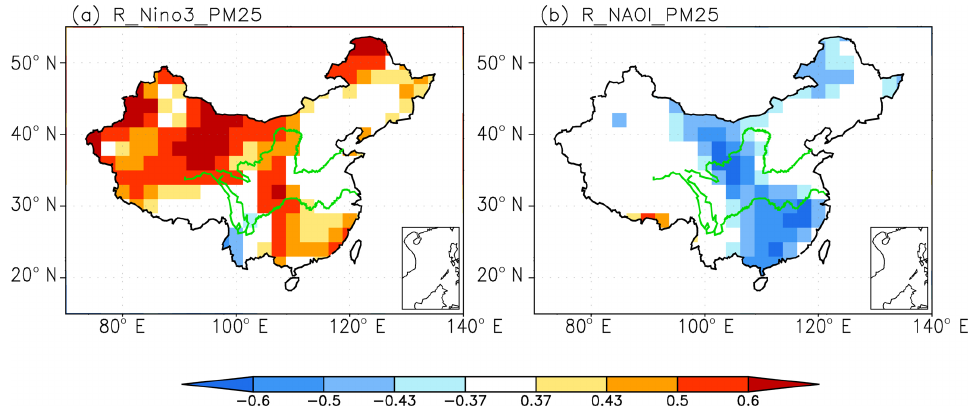
Figure 3. (a) The spatial distribution of the correlation coefficients between surface-layer PM 2 . 5 concentrations and the Niño3 index. (b) As in (a) but for correlations with the NAOI. Color shading indicates a significant correlation at the 0.1 level (0.37 is the critical value for significance at the 0.1